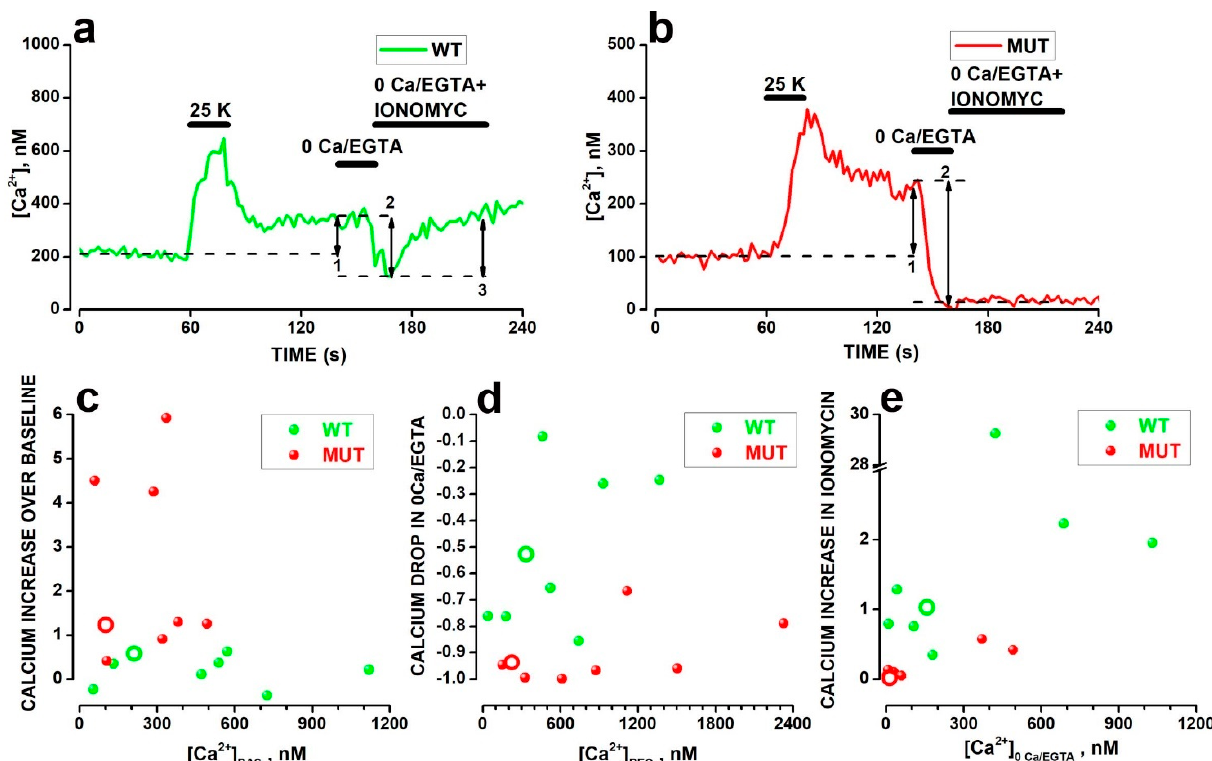
Figure 3. ( a , b ) Changes in [Ca 2+ ] in response to the 20 s-long application of saline with 25 mM [K] o in WT ( a ) and MUT ( b ) rods. Double arrow lines labeled 1: increase in [Ca 2+ ] after the application of saline with 25 mM [K] o . Double arrow lines labeled 2: decrease in [Ca 2+ ] in response to saline containing no-added calcium and 5 mM EGTA. Double arrow line labeled 3: increase in [Ca 2+ ] induced by calcium stores’ release in response to 60 s-long application of saline containing no-added calcium, 5 mM EGTA, and the calcium ionophore ionomycin (10 µM) (double arrow line labeled 3 in ( a )). ( c – e ) Circles plot the increase in [Ca 2+ ] over baseline ( c ), [Ca 2+ ] drop in 0 Ca/EGTA ( d ), and increase in [Ca 2+ ] induced by ionomycin in 0 Ca/EGTA ( e ) for eight WT (green) and eight MUT (red) rods. Open circles in ( c – e ), plot values measured in rods in ( a , b ). The mean relative calcium increases over base- line (([Ca 2+ ] RECOV − [Ca 2+ ] BASELINE )/[Ca 2+ ] BASELINE )) was significantly different between WT (0.21 ± 0.13) and MUT (2.48 ± 0.74) rods (t = − 3.03682, 14 df: p = 0.00888). Mean baseline [Ca 2+ ] levels did not differ significantly between WT (477.65 ± 123.66 nM) and MUT (260.43 ± 54.79 nM) rods (t = 1.60603, 14 df: p = 0.13058). The mean relative drop in calcium (([Ca 2+ ] 0Ca/EGTA − [Ca 2+ ] REC )/[Ca 2+ ] REC )) from its level before application ([Ca 2+ ] REC ) of 0Ca/EGTA saline was signi fi cantly larger in MUT ( − 0.91 ± 0.04) than in WT ( − 0.52 ± 0.10) rods (t = 3.52768, 14 df: p = 0.00335). The mean ratio between [Ca 2+ ] increase in response to ionomycin and the drop in 0 Ca/EGTA is significantly larger in WT (1.20 ± 0.26) than in MUT (0.17 ± 0.07) rods (t = 4.10383, 13 df: p = 0.00124), after dropping an outlier in the WT group.